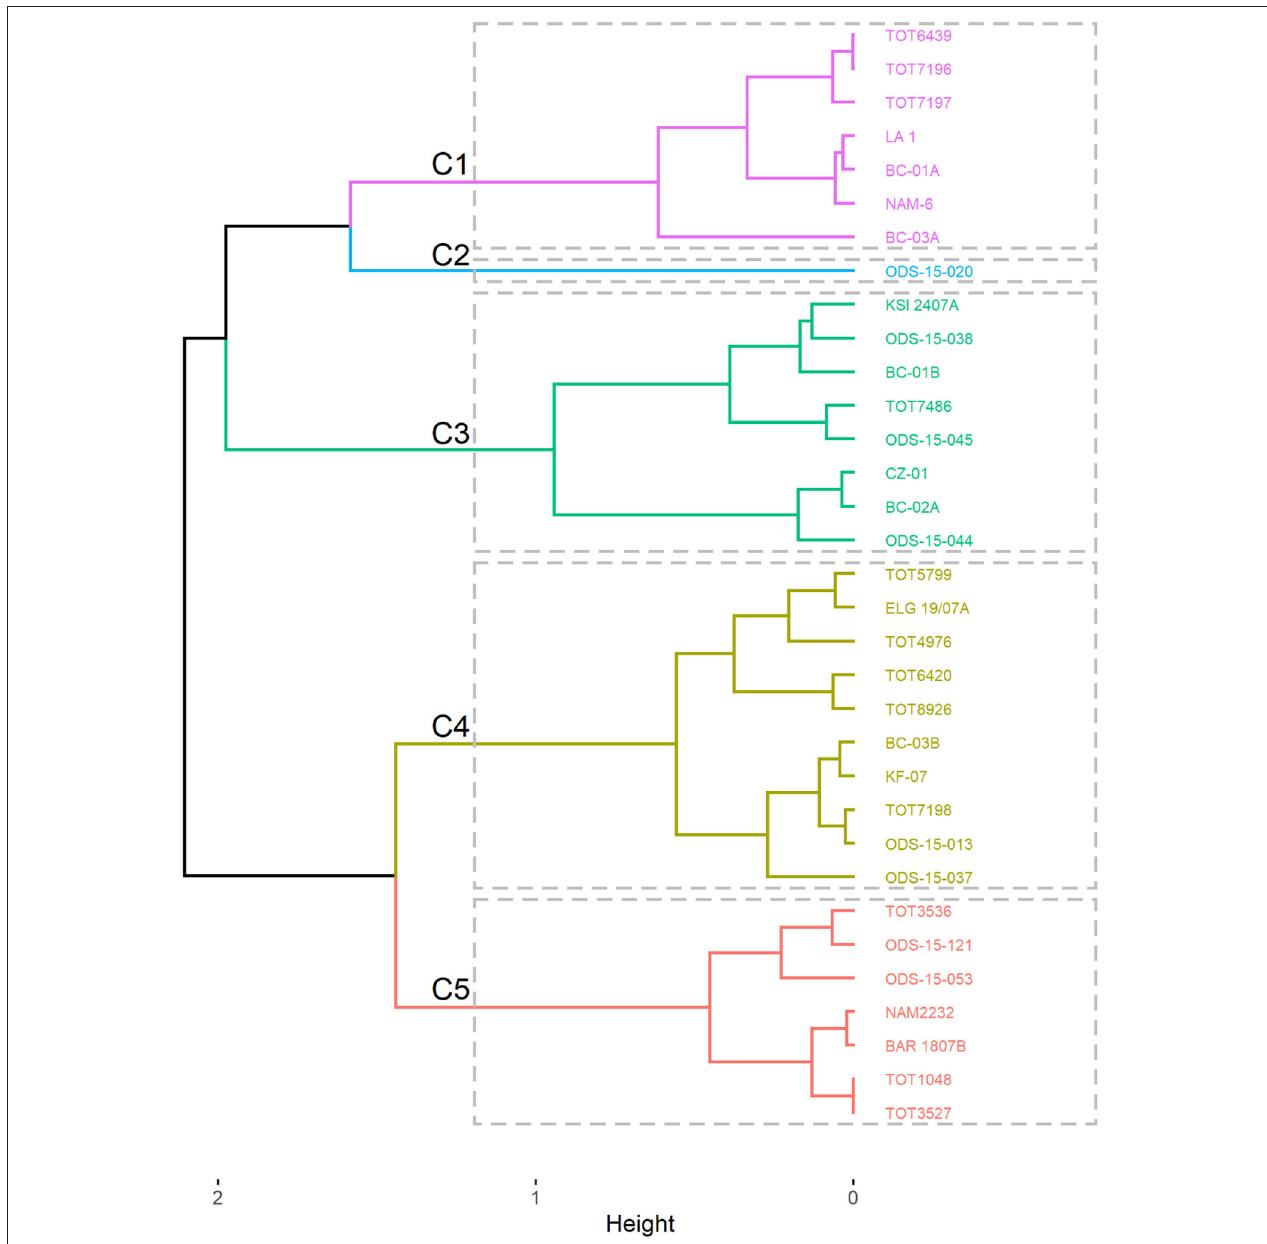
FIGURE 6 | Dendrogram showing the grouping of the 33 accessions of Gynandropsis gynandra into